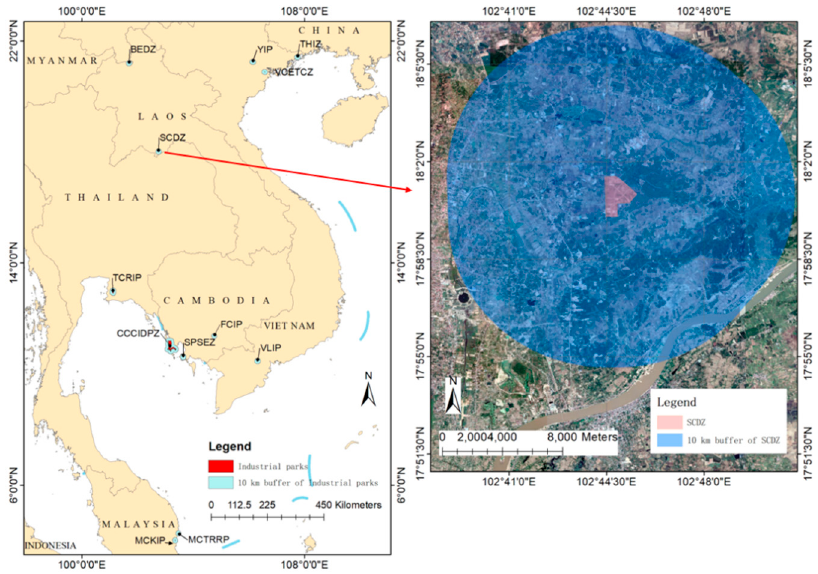
Figure 2. Location map of China’s Industrial Parks in Southeast Asia.